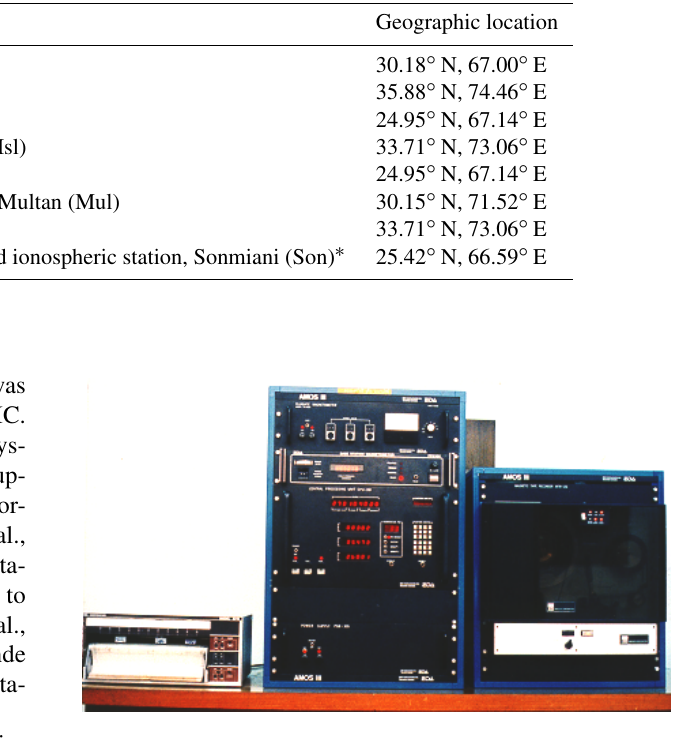
Figure 3. Automatic Magnetic Observatory System-III (AMOS-